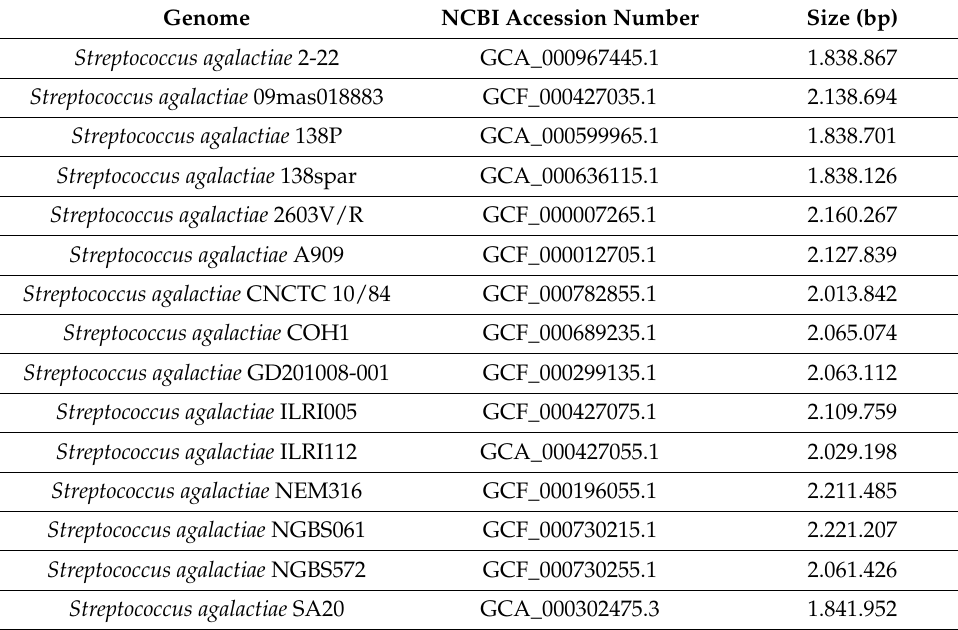
Table 4. Complete Streptococcus agalactiae genomes used in the nucleotide identity comparison performed with the BRIG